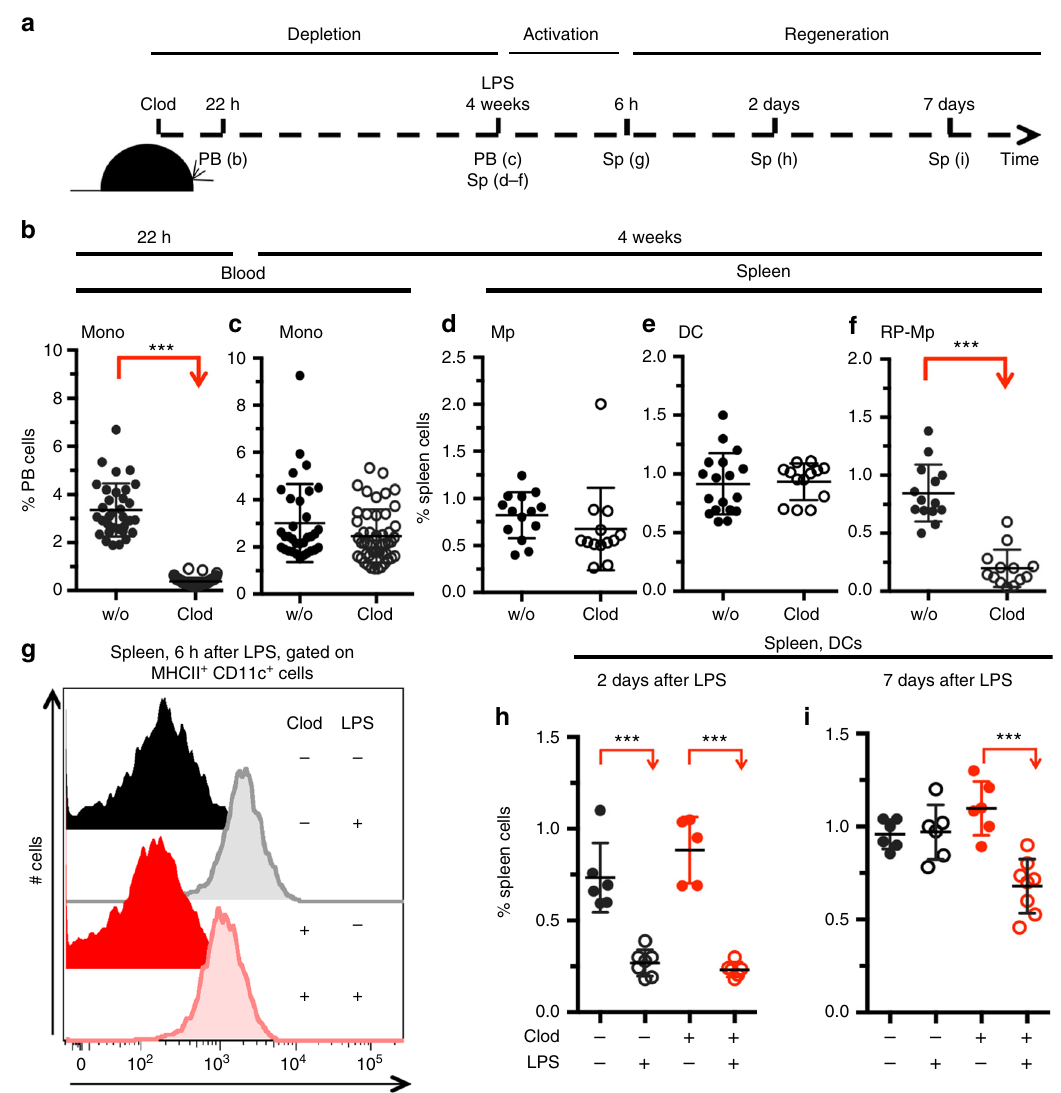
Fig. 6 RP-Mps in the adult spleen are crucial for the regeneration of DCs after activation-induced depletion in vivo. a Schematic outline of the experiment. b Plot shows the depletion of blood monocytes 22 h after injection of chlodronate-coated liposomes (Clod). SD is shown. c Plot shows blood monocyte regeneration 4 weeks after Clod injection. SD is shown. d , e Plots show normal frequencies of spleen macrophages ( d ) and DCs ( e ) 4 weeks after Clod injection. SD is shown. f Plot shows reduced frequencies of spleen RP-Mps 4 weeks after Clod injection. SD is shown. g Histograms show the expression of CD86 on spleen DCs 6 h after injection of LPS in indicated test groups. h , i Plots show the frequencies of DCs in mice that have or have not received Clod 4 – 5 weeks before and that were injected with LPS 2 ( h ) or 7 ( i ) days before. Data are pooled from three independent experiments. Two-sided t tests were performed and SD is shown throughout the fi gure. SD are